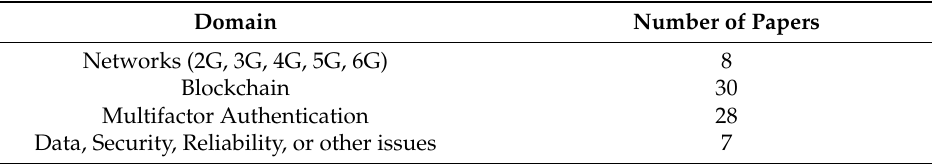
Figure 1. Research methodology (Phase 1 and Phase 2). Table 2. Summary of included research